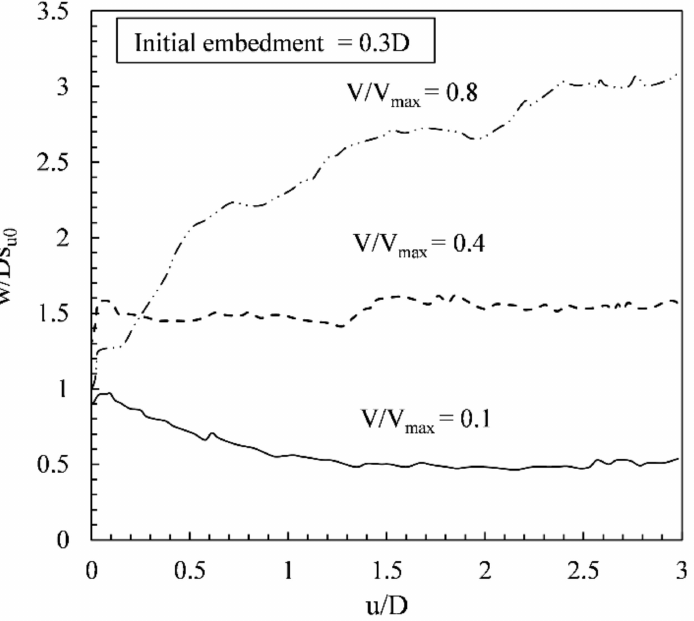
Figure 8. Variation of normalised lateral resistance of a partially buried pipeline with pipe displace- ment and pipe weight